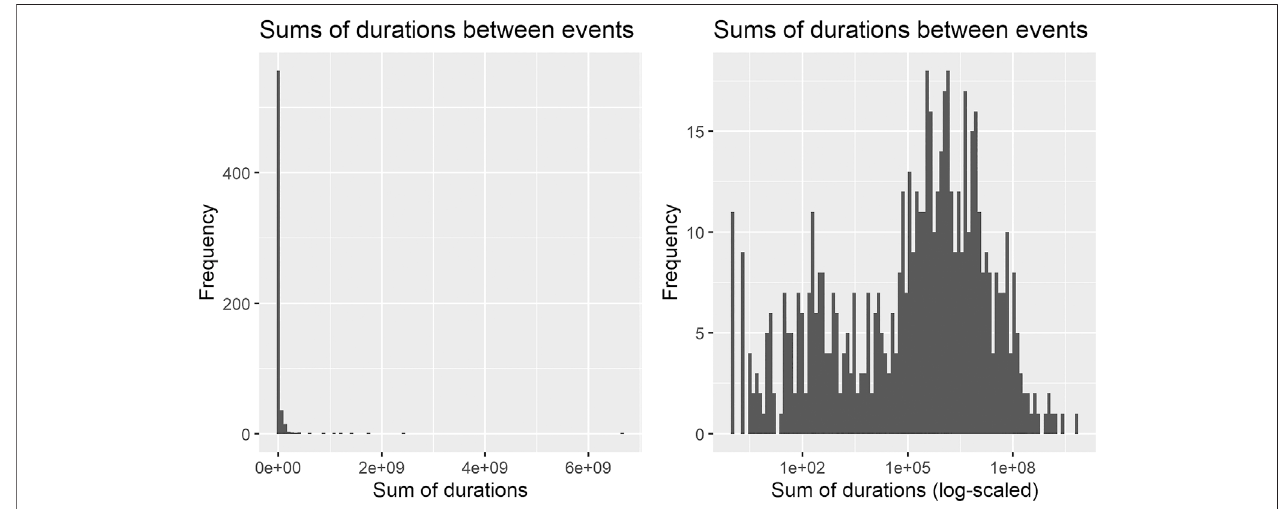
FIGURE 2 | Histograms of sums of durations between successive events in the process: The distribution is skew to the left; the log-scaled distribution is better leveled (Remark: 14 durations of length 0 are left out in the logarithmized plot).